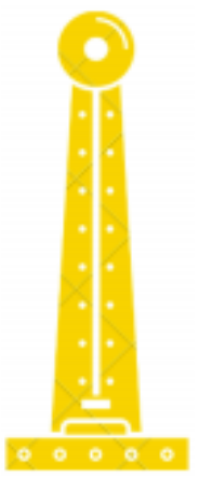
Figure 5. Interface of the game “Force